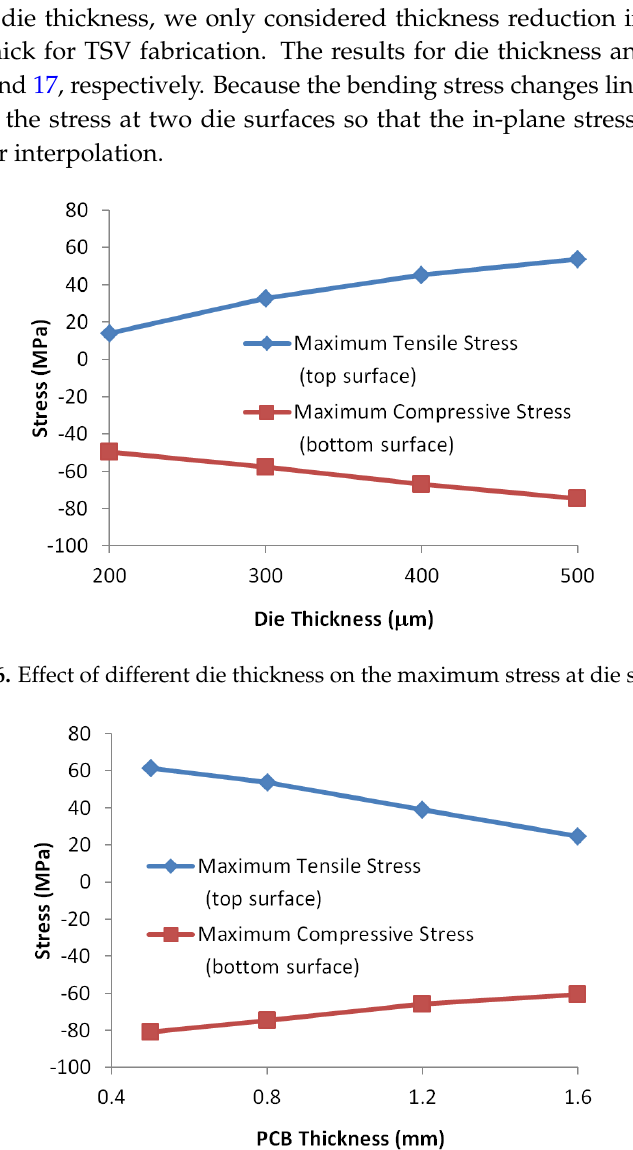
Figure 17. Effect of different PCB thickness on the maximum stress at die surfaces.